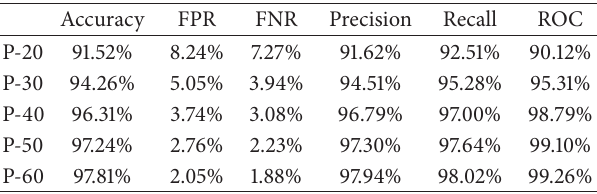
Table 1: The results of DDoS detection in normal traffic. Table 2: The results of DDoS detection in flash crowd.